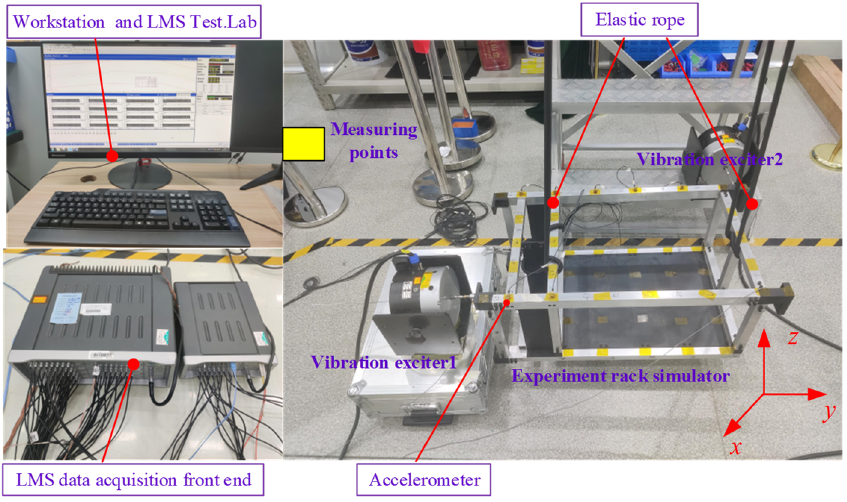
Figure 4. Free modal test site of experiment rack simulator.